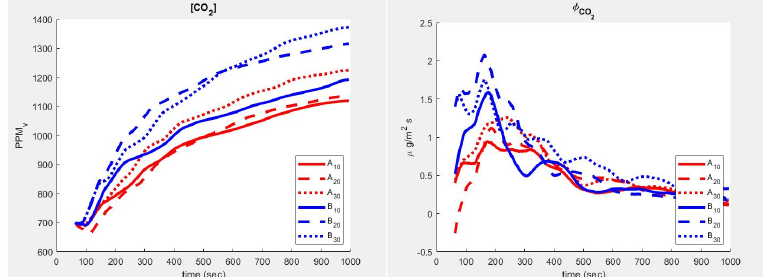
Figure 8. CO 2 concentration response to 1 s human breath in the open